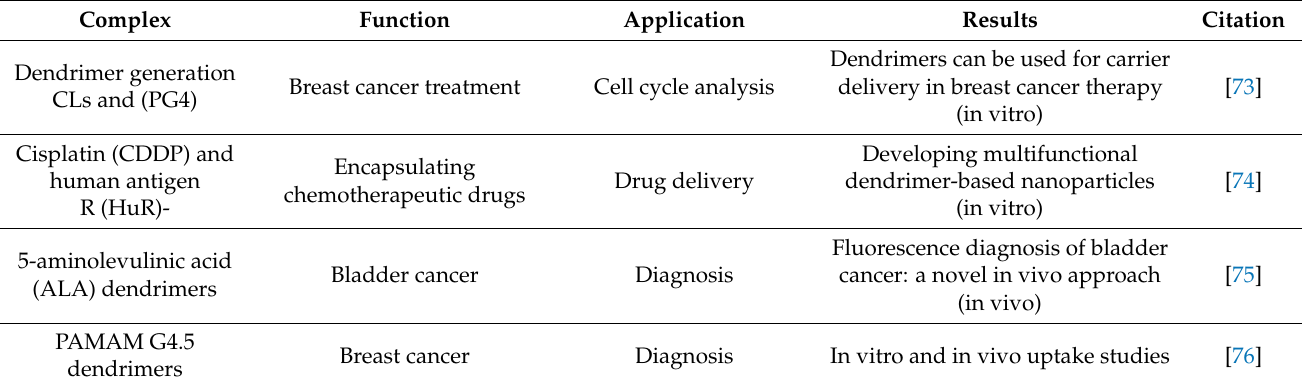
Figure 8. The structure and application of dendrimers in drug encapsulation and conjugation. Table 9. Application of dendrimers in cancer detection and cancer